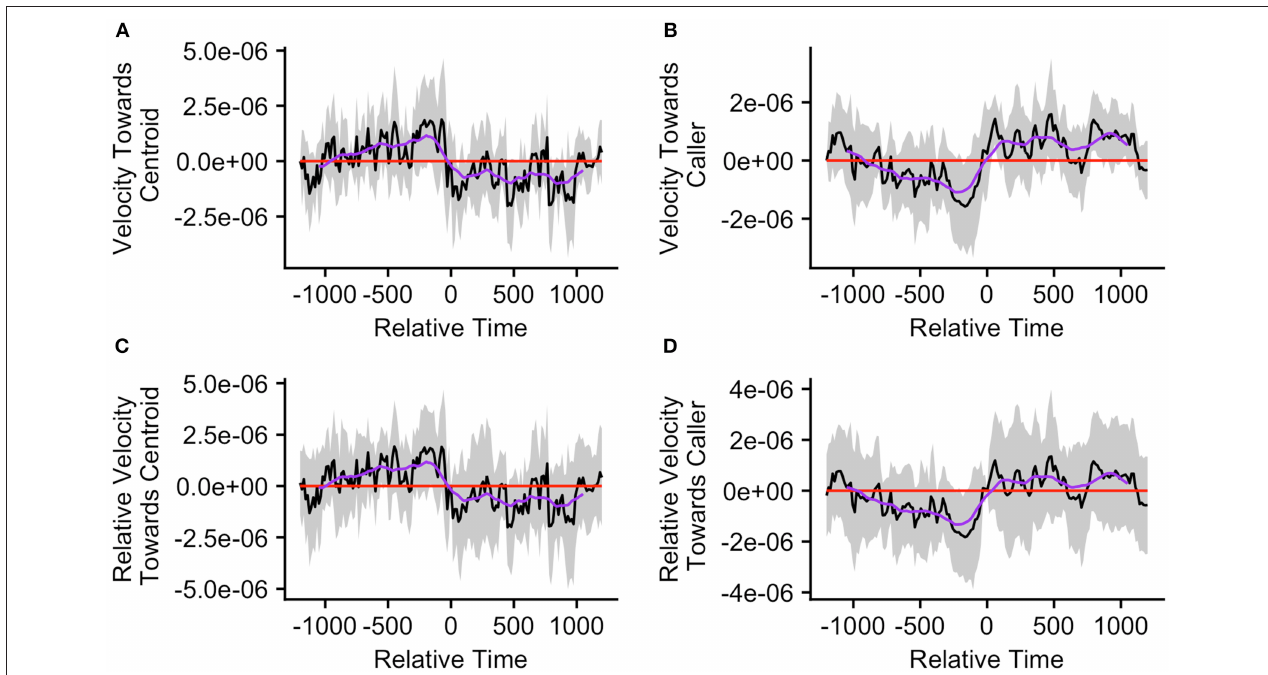
FIGURE 8 | The upper graphs show the mean velocity with 95% confidence interval of the (A) caller toward the group centroid and (B) group centroid toward the caller, from 20min before to 20min after the production of the first call (relative time = 0) in a call bout. Data are presented for bouts assigned to cluster 2 ( n = 18 calling bouts), which correspond with bouts in which callers are close to the centroid at the time of the call. The lower graphs show the mean difference in velocity (with 95% confidence interval) of the (C) caller toward the group centroid and (D) group centroid toward the caller compared to their own velocities at the time of the call (relative time = 0). The purple line represents the simple moving average of each plotted velocity calculated with a window of 301s centered on each